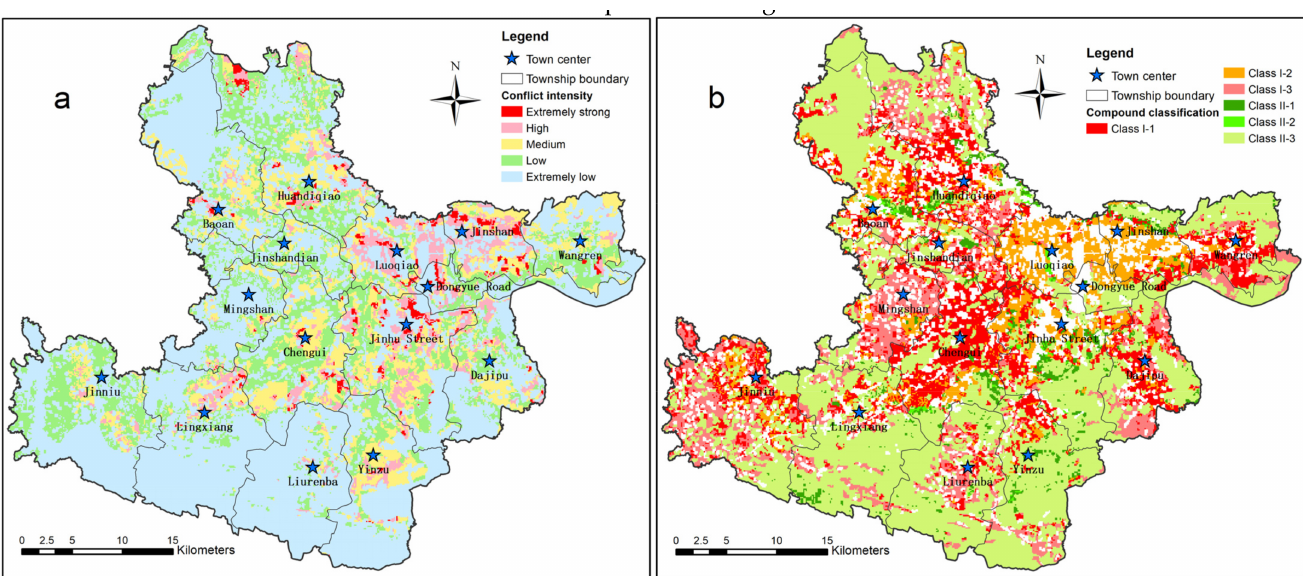
Figure 4. ( a ) The spatial distribution of LUC of different intensities in the study area. ( b ) The compound classification and spatial distribution of LUC in the study